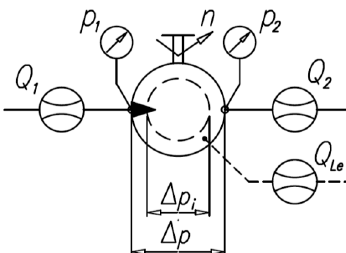
Figure 1. Symbol of hydraulic motor with measuring instruments: Q 1 , Q 2 and Q Le —flowmeters, p 1 and p 2 —pressure gauges, n —speedometer, Δ p —pressure drop in motor, Δ p i —pressure drop in motor working chambers.